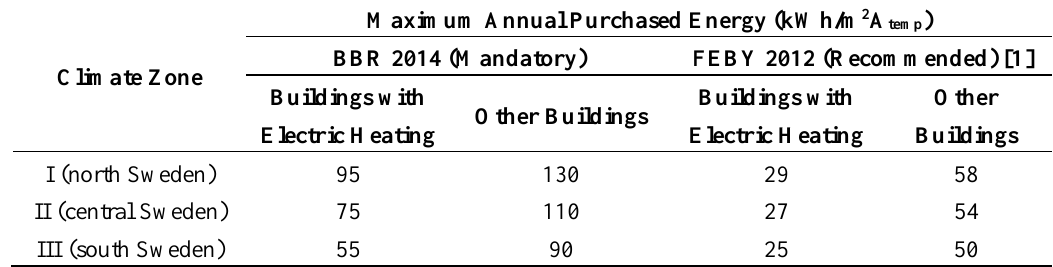
Table 1. Specific energy use of residential buildings in Sweden according to the requirements of the building code (BBR) and the recommended Forum för energieffektiva byggnader (FEBY) 2012 passive house